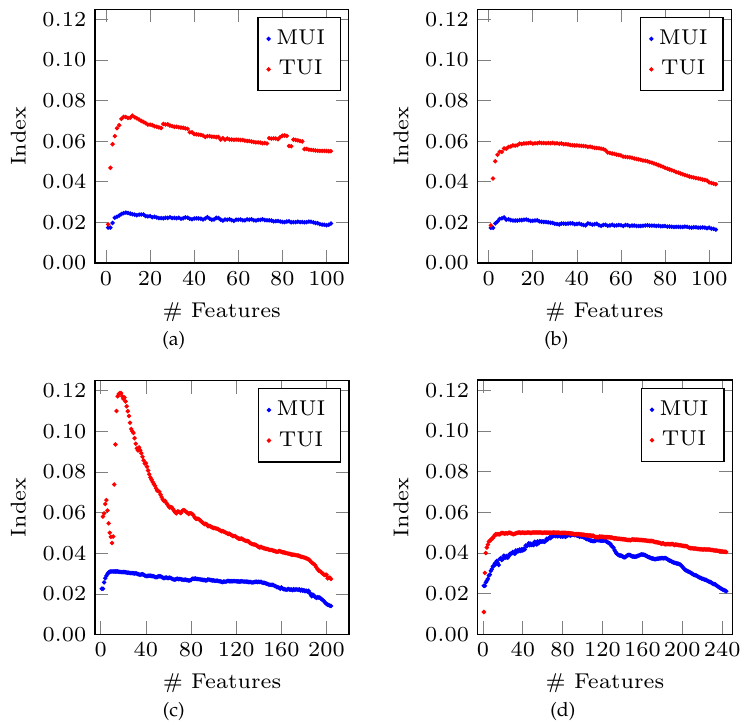
Figure 5. Behavior of the Murtagh Ultrametricity Index (MUI) and the Topological Ultrametricity Index (TUI) for an increasing number of the involved best-ranked features: the single plots correspond to ( a ) the Pavia Centre dataset; ( b ) the Pavia University dataset; ( c ) the Salinas dataset and ( d ) the EnMAP dataset.